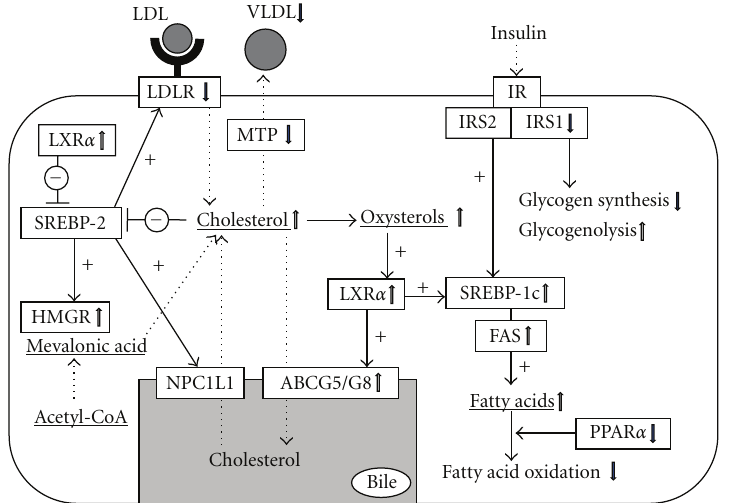
Figure 1: Expression profile of lipid metabolism-associated factors in chronic hepatitis C. ABCG5/G8, ATP-binding cassette G5/G8; FAS, fatty acid synthase; HMGR, HMG-CoA reductase; IR, insulin receptor; IRS, insulin receptor substrate; LDLR, LDL receptor; LXR α , liver X receptor α ; MTP, microsomal triglyceride transfer protein; NPC1L1, Niemann-Pick C1-like 1; PPAR α , peroxisome proliferator-activating receptor α ; SREBP, sterol regulatory element-binding